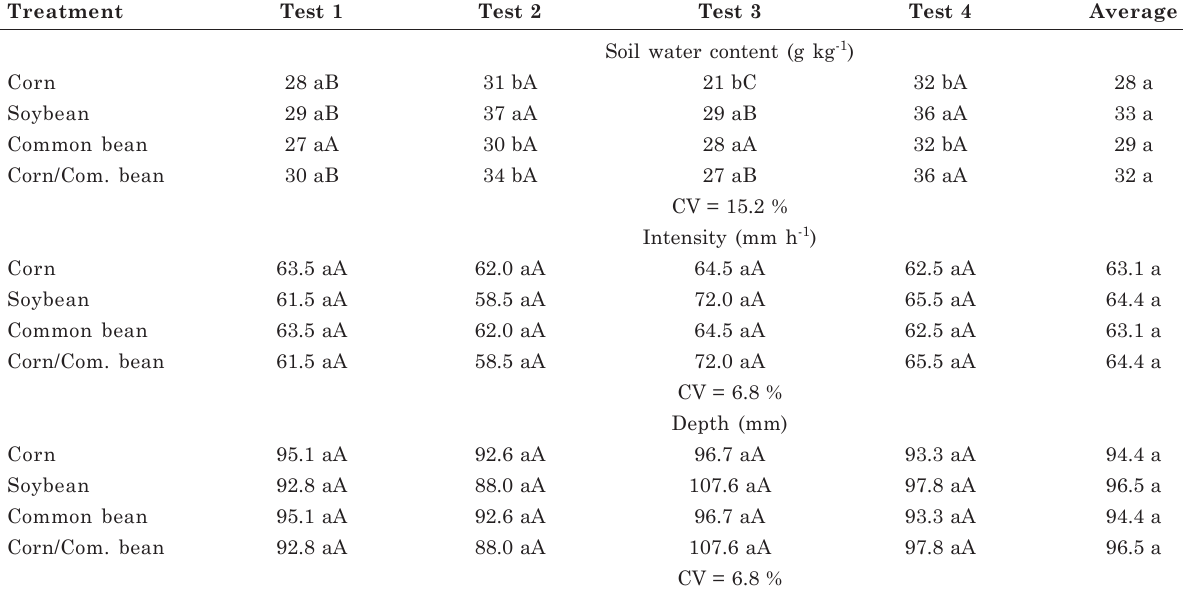
Table 1. Soil water content, before the beginning of simulated rainfalls, and intensity and depth of the applied simulated rainfalls, 90 min duration, under four treatments and rainfall tests, in a Humic Dystrudept